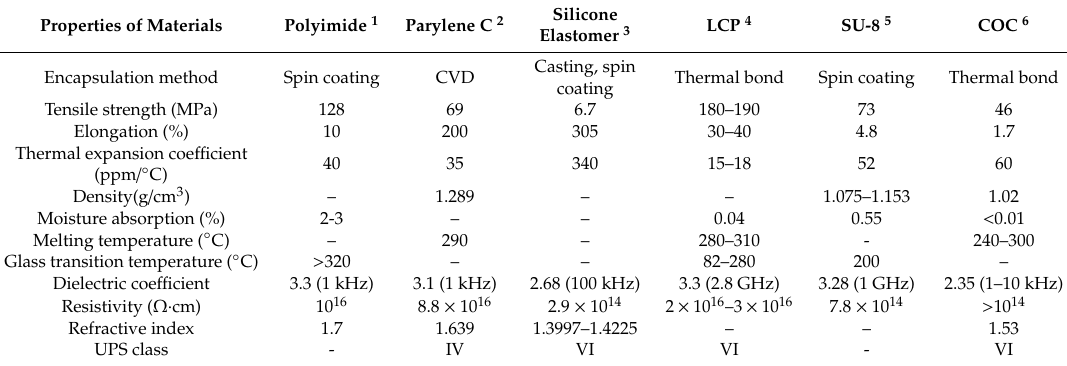
Table 2. Properties of organic encapsulation materials for implantable